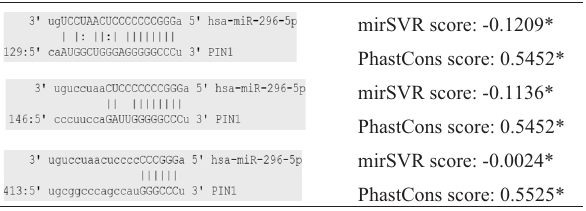
Table 1 - miR-296-5p/ PIN1